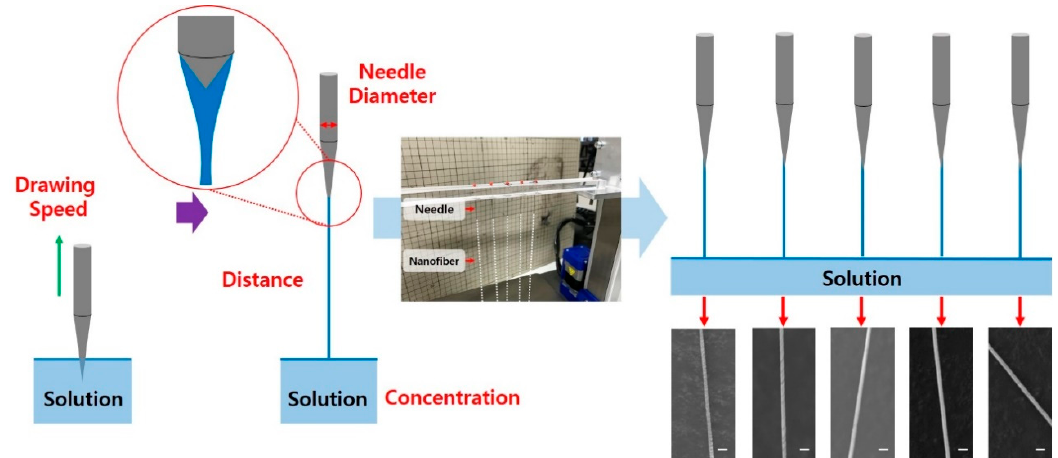
Figure 6. The needle spinning apparatus, and SEM images of nanofibers fabricated from needles at different locations in the same batch (scale bar = 2 μ m). [Adapted with permission from 64. Copyright (2018) MDPI].